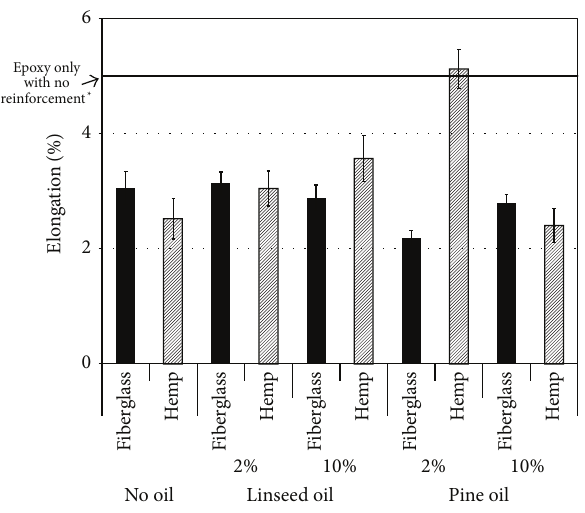
Figure3:Percentelongationforepoxycompositeswithandwithout oil addition. ∗ Data taken from TAP Plastics product bulletin [21].